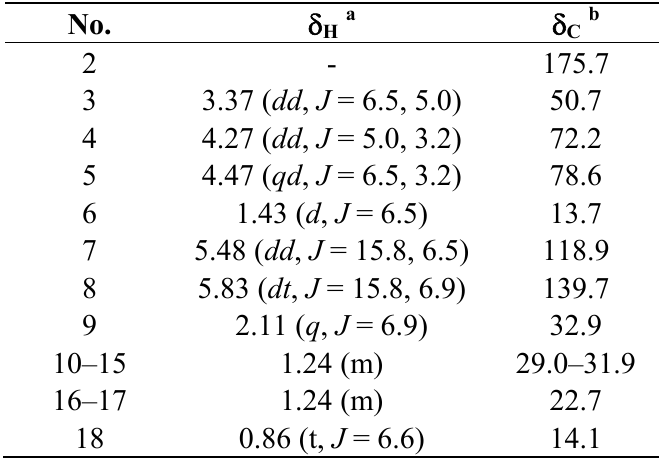
) of 1 .  in ppm, J in Hz. 3